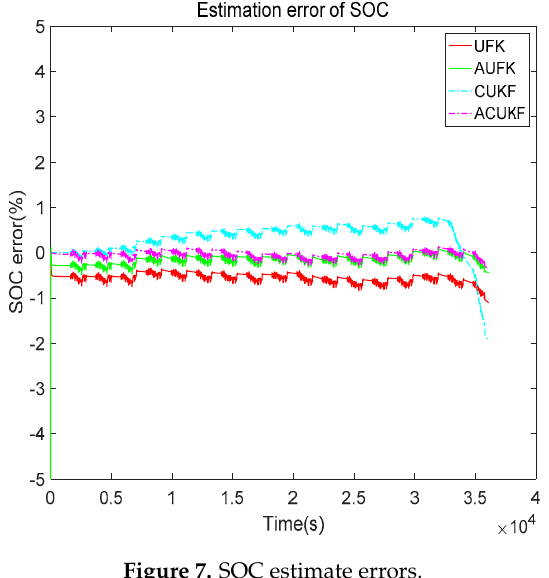
Figure 7. SOC estimate errors. Table 2. Evaluation results for different SOC estimation methods.